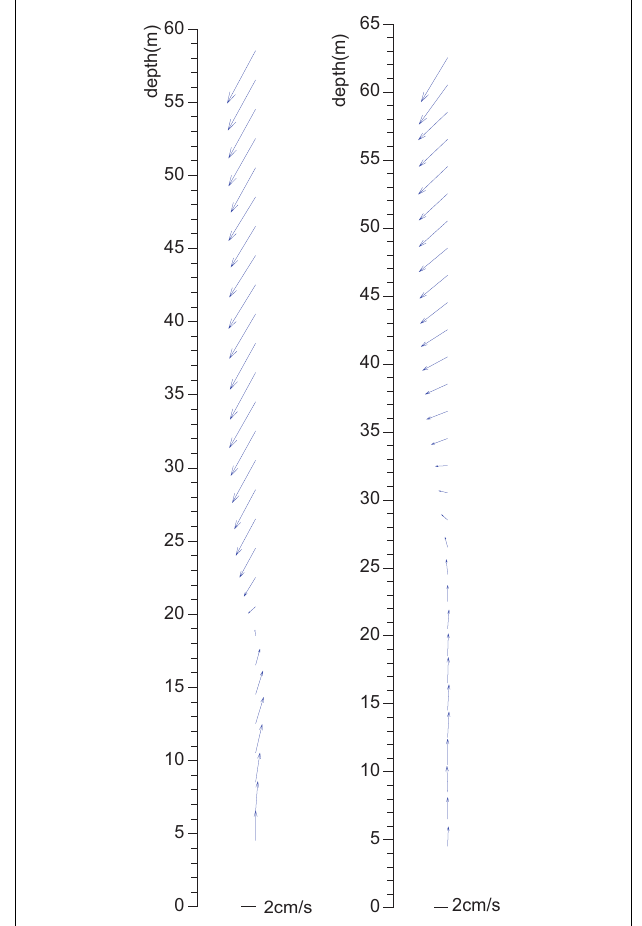
evolution patterns of the southern YSCWM and YSWC